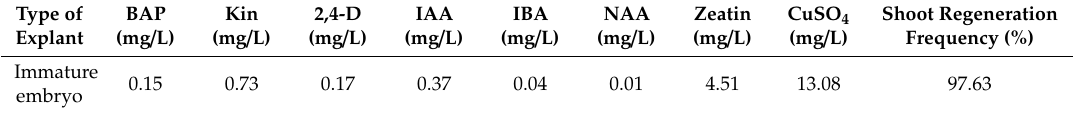
Table 2. The optimized solution for shoot regeneration achieved by using GRNN-GA in wheat.